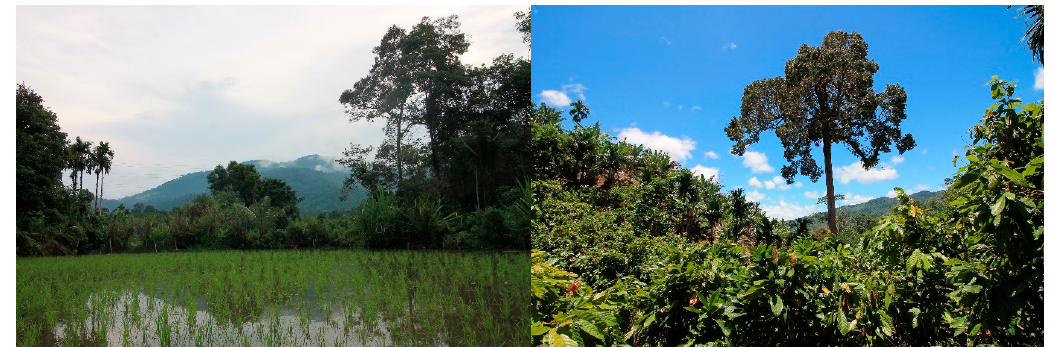
Figure 3. Traditional landscape in the study area (rice field in Simpang village on the left; cocoa agroforestry in Sontang village on the right, July 2017).